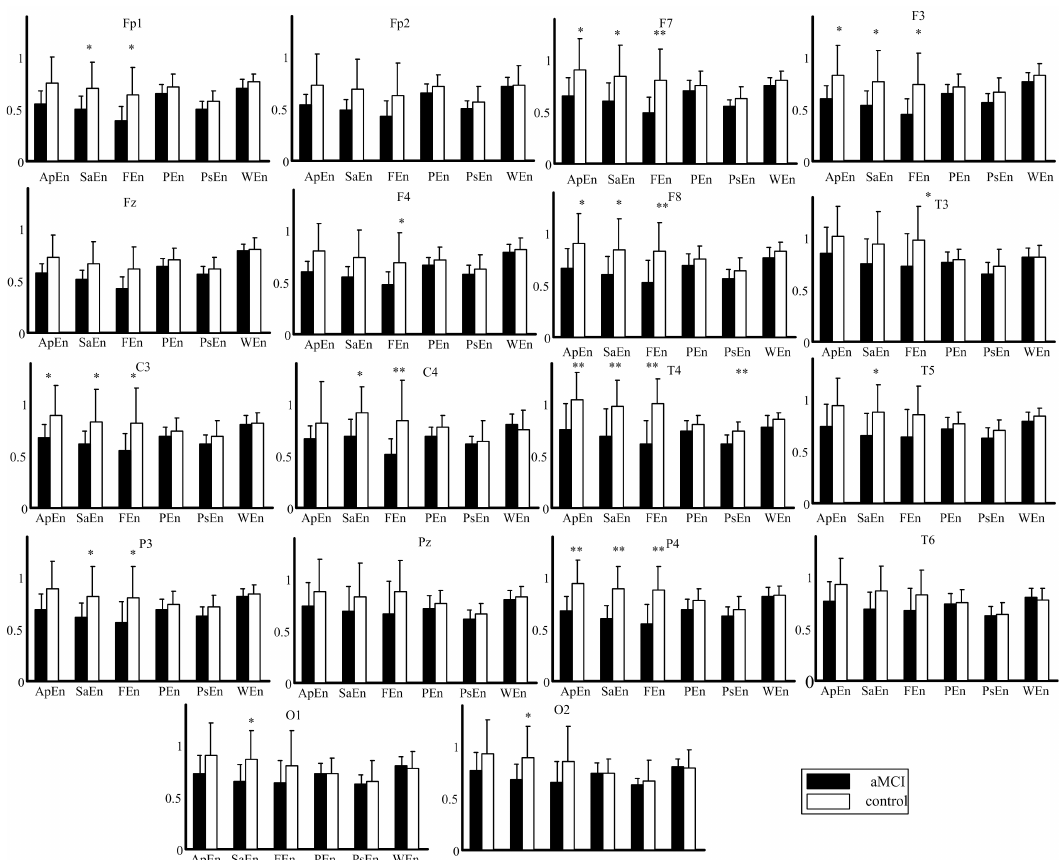
Fig. 4. The ApEn, SaEn, FEn, PEn, PsEn and WEn based on EMD at all electrodes (mean (cid:1) standard error) between aMCI group (black) and control group (white). Results of ANOVA were the following: there was the signi¯cant group e®ect for the ApEn based on EMD ( F ð 1 ; 21 Þ ¼ 3 : 324, p < 0 : 001), the SaEn based on EMD ( F ð 1 ; 21 Þ ¼ 3 : 662, p < 0 : 001), the FEn based on